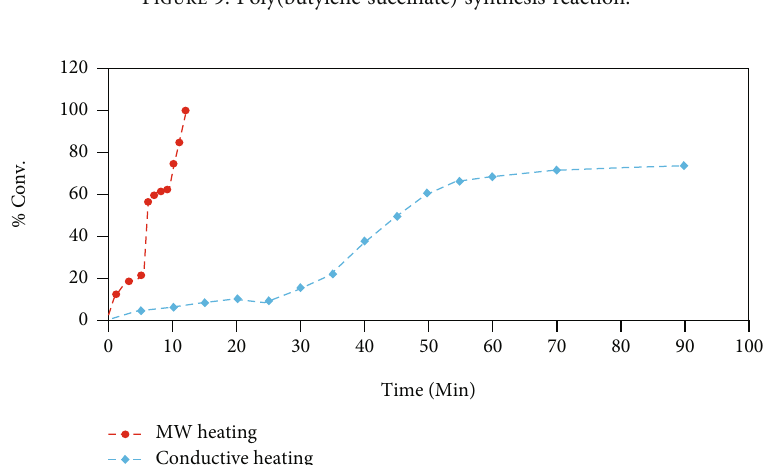
Figure 10: Methyl methacrylate conversion monitoring, reproduced from the results given as table by Sierra et al. [37] with permission (copyright © 2006, Taylor & Francis Group,